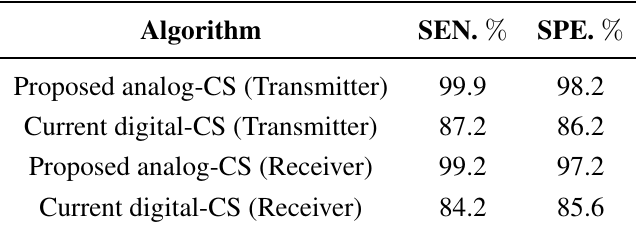
Table 5. Comparison of analog-CS and